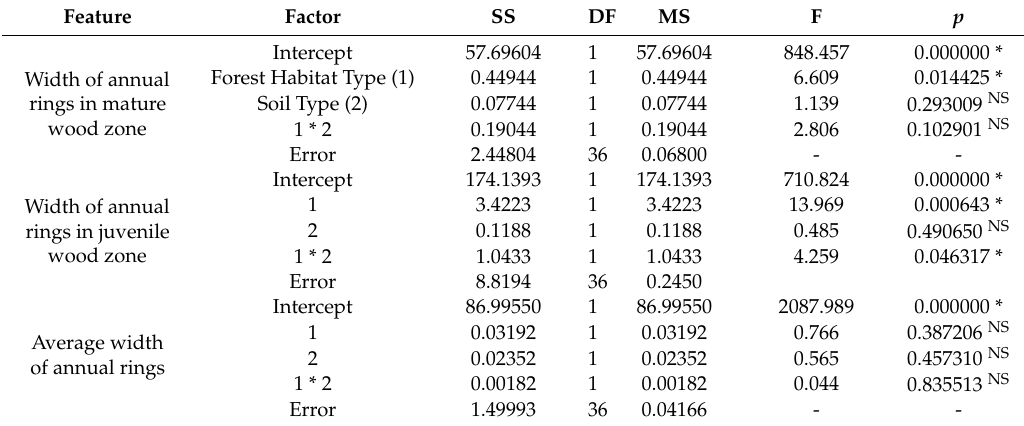
Table 5. Values of ANOVA for annual ring widths in trunks of pine trees depending on the forest habitat and previous land